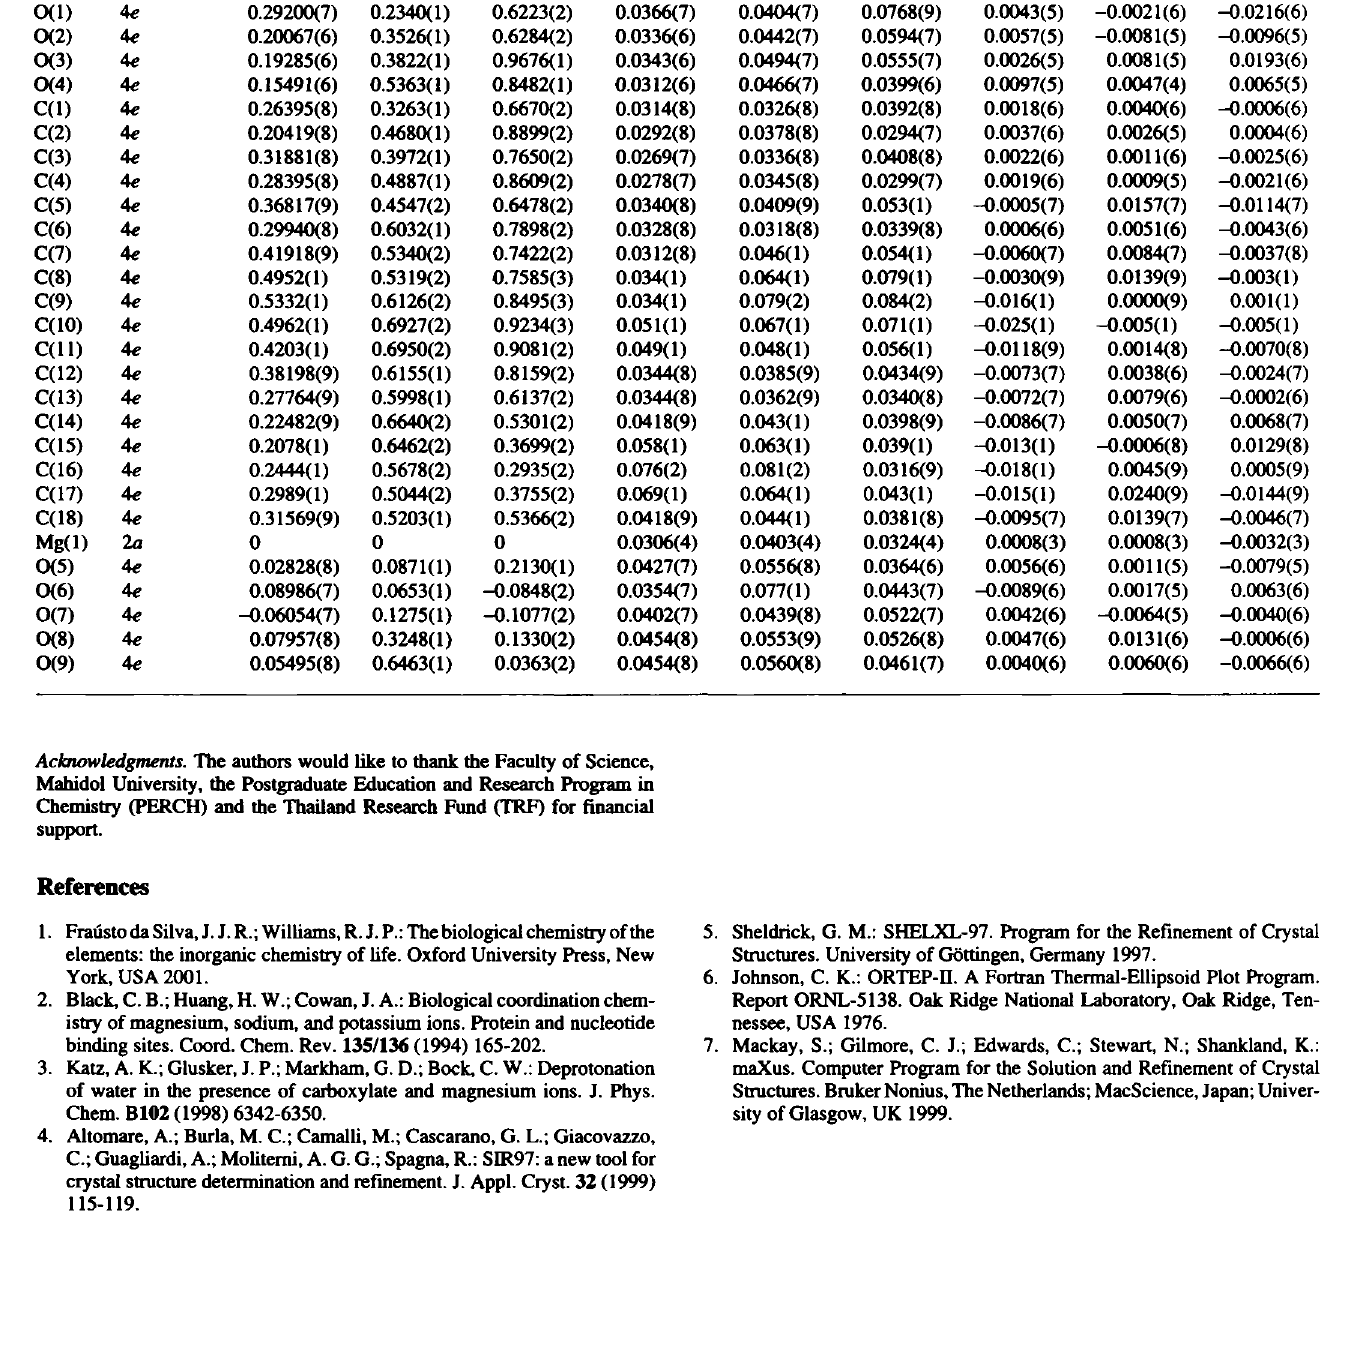
Table 3. Atomic coordinates and displacement parameters (in Â 2